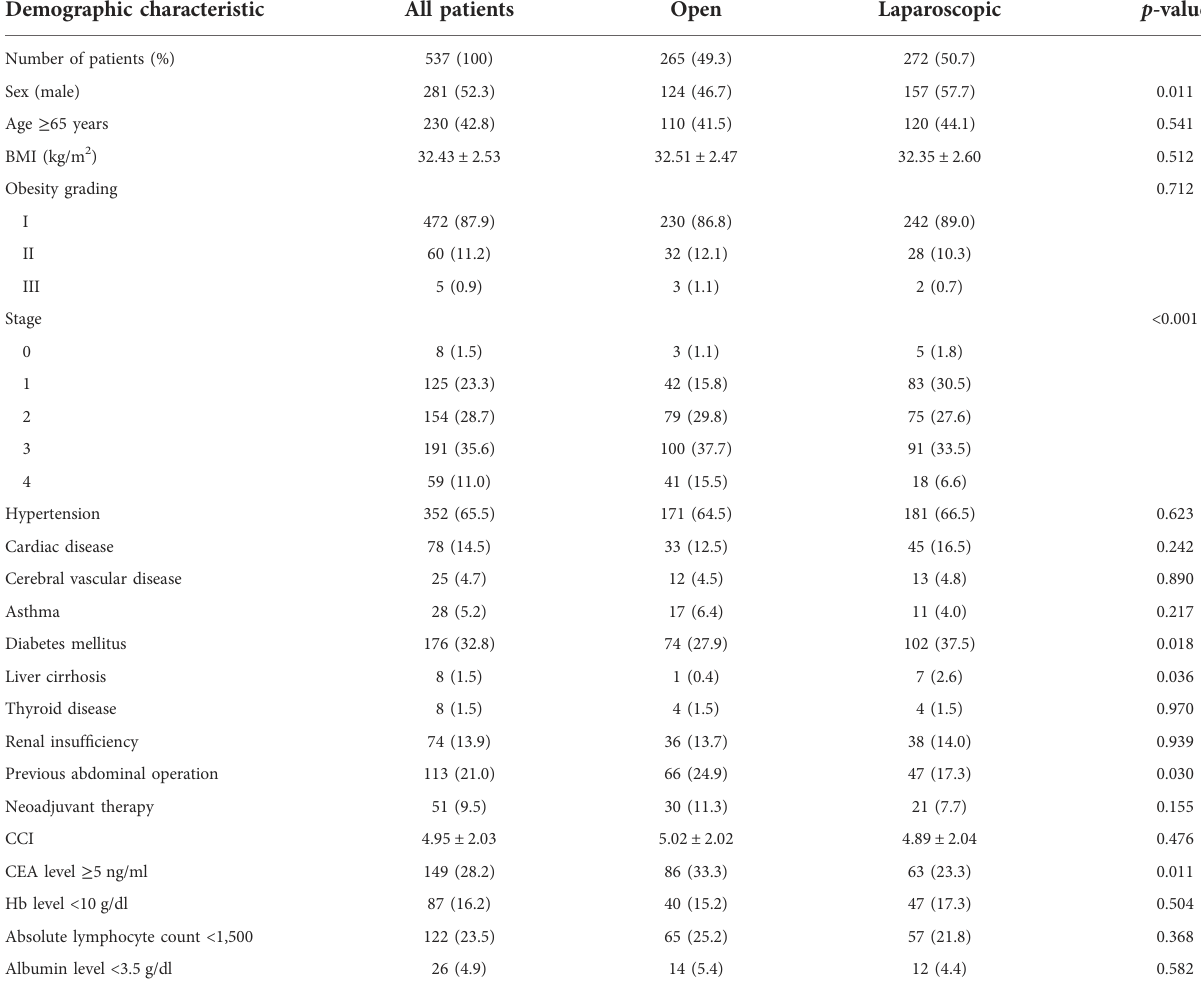
TABLE 1 Clinical demographic characteristics of the study patients. Demographic characteristic All